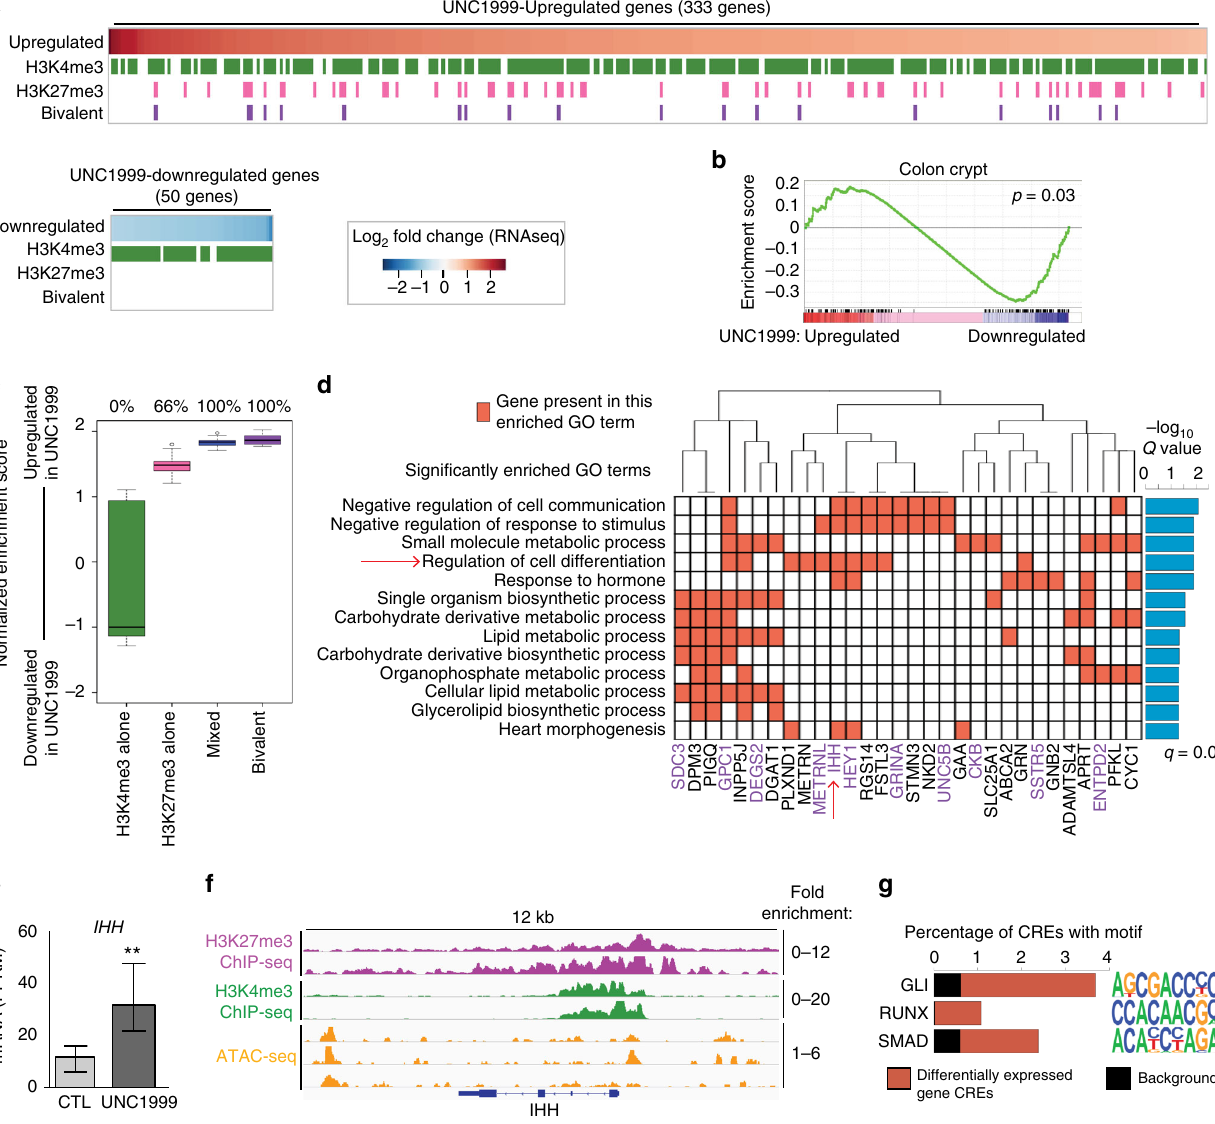
Fig. 4 EZH2 Inhibition de-represses the colonic differentiation gene IHH . a RNA-seq heatmap of log 2 fold change for all genes signi fi cantly upregulated (red in top panel) or downregulated (blue in bottom panel) following UNC1999 treatment in POP92 cells. Lower bars underneath the heatmap indicate ChIP-seq data for POP92 cells in the absence of UNC1999. The presence of H3K4me3 peaks (green), H3K27me3 peaks (pink) or regions where both marks directly overlap (Bivalent; purple) in promoter regions (2.5kb upstream of TSS, 0.5kb downstream of TSS) is shown (prior to UNC199 treatment) for all genes whose expression is signi fi cantly changed after UNC1999 treatment (negative binomial, FDR-corrected q <0.05). RNA-Seq was performed in ( n = 3) biological replicates for each condition, ChIP-seq peaks called in n = 2 separate replicates were used for each mark. b GSEA performed on the differentially regulated transcripts from RNA-seq data with respect to the Colon Crypt signature (FWER, p <0.03). c GSEA performed on 30 randomly selected sets of 200 genes with H3K4me3 (green), H3K27me3 (pink), mixed (blue) or bivalent (purple) marks in their promoters. Distribution of normalised enrichment scores are shown along with the percentage of runs which were signi fi cantly enriched among upregulated genes following UNC1999 treatment ( p < 0.25, none were signi fi cant among downregulated genes). d Enriched biological process GO terms within all genes differentially upregulated following UNC1999 treatment with H3K27me3 marks in their promoter. Matrix shows which differentially expressed genes are present in each GO category, barplot shows − log 2 FDR- corrected q-value. Genes with bivalently marked promoters are highlighted in purple. e Boxplot of differential expression of IHH following UNC1999 treatment (mean of n = 3), error bars show max and min estimated FPKM values, Student ’ s t test. f Representative ChIP-Seq tracks for H3K27me3 and H3K4me3 showing read counts over the IHH locus inclusive of the promoter region. g Transcription factor motif analyses performed on the predicted CREs (de fi ned using ATAC-Seq) of UNC1999-differentially upregulated genes using homer, relative to a background of all ATAC-Seq peaks. ** P